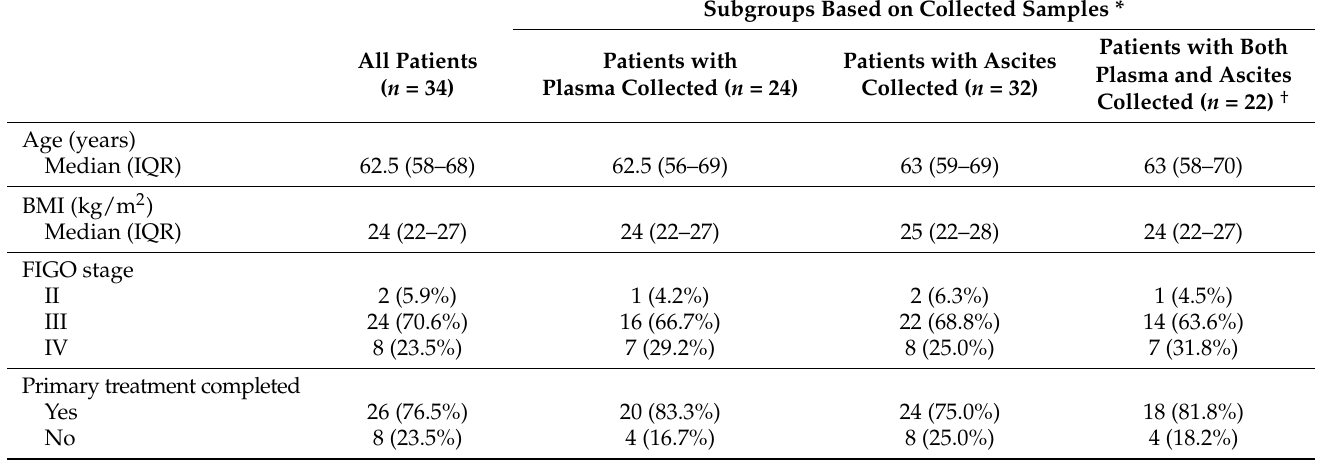
BMI: body mass index; FIGO: International Federation of Gynecology and Obstetrics; IQR: interquartile range. Percentages may not total to 100% due to rounding. * Samples from remaining patients were missing for